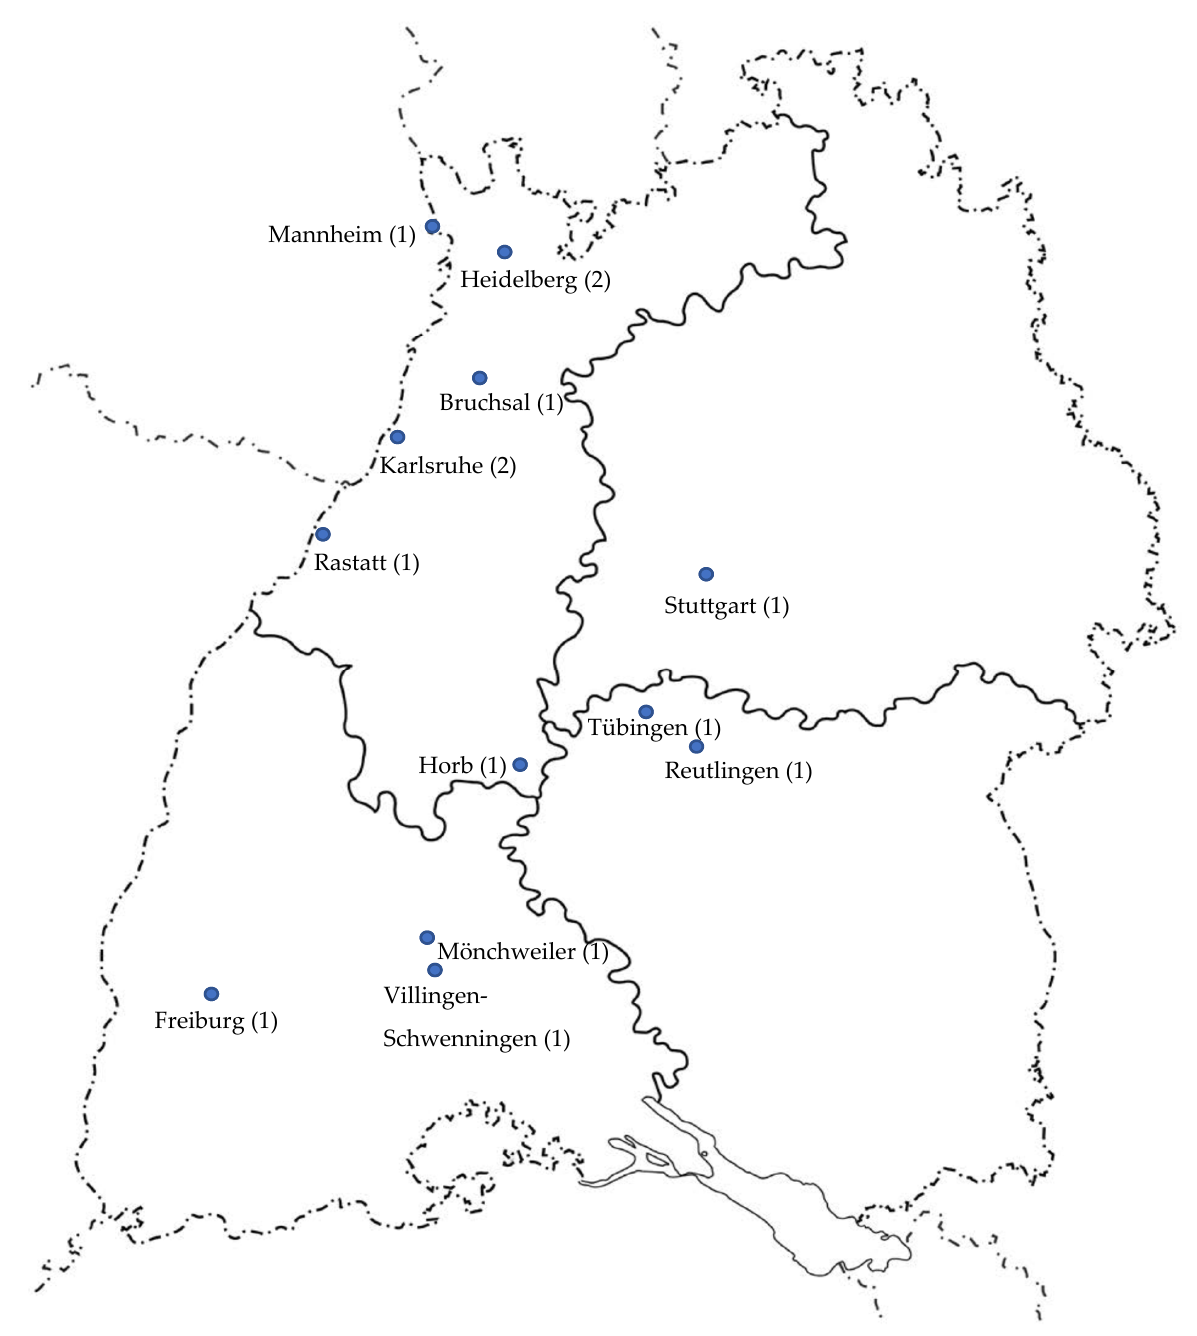
Figure 1. Study’s sample points.